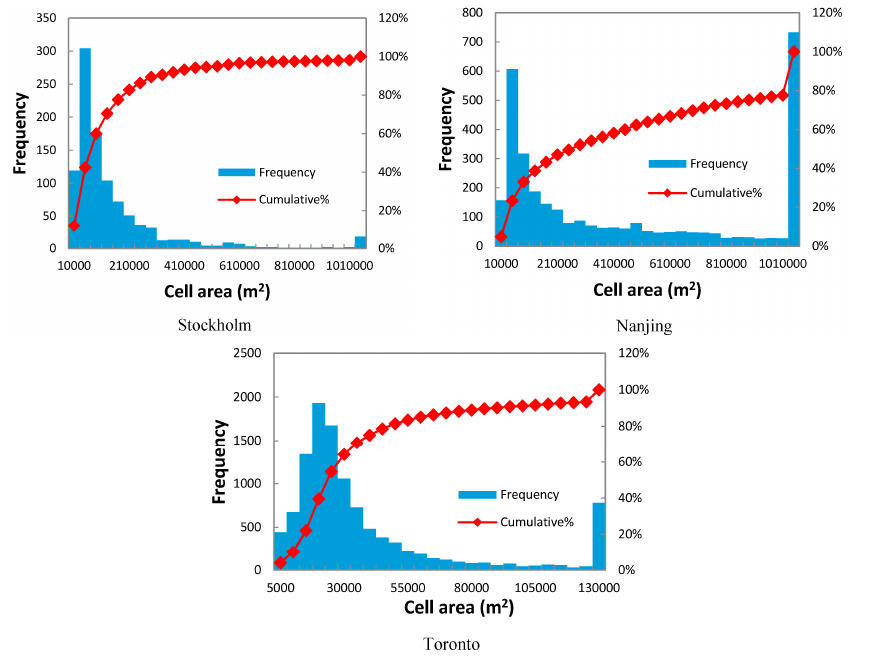
Figure 3. Distribution histograms of the cell area of urban street systems of Stockholm, Nanjing, and Toronto.